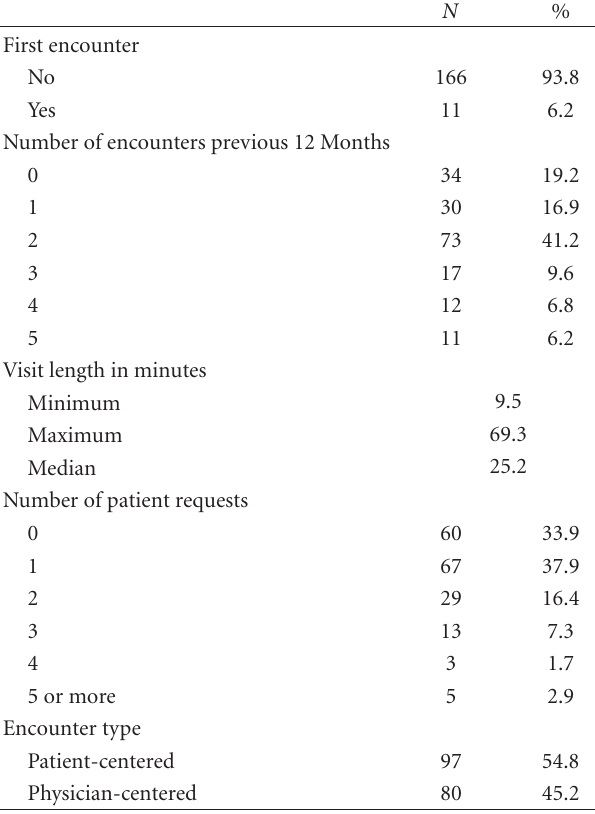
Table 4: Characteristics of the medical encounters ( n = 177).